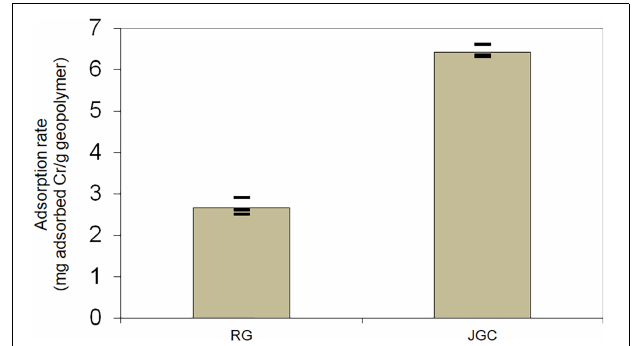
FIGURE 7 | Adsorption of Cr(III) (period: 24 h, pH = 5, Each bar represents the measurement of the individual